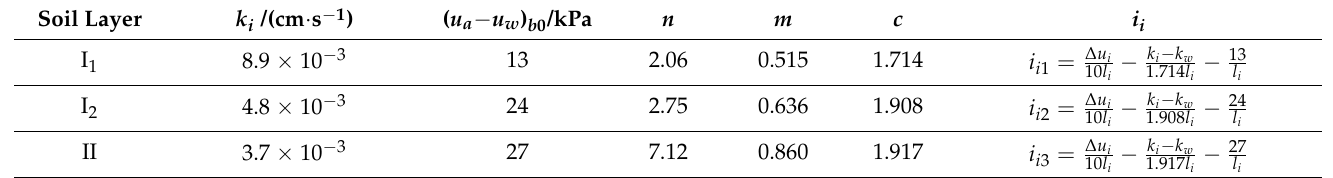
Table 2. Soil unsaturated parameters and hydraulic gradient calculation formula of three soils. Soil